Question: Provide a one-line summary of what is displayed.
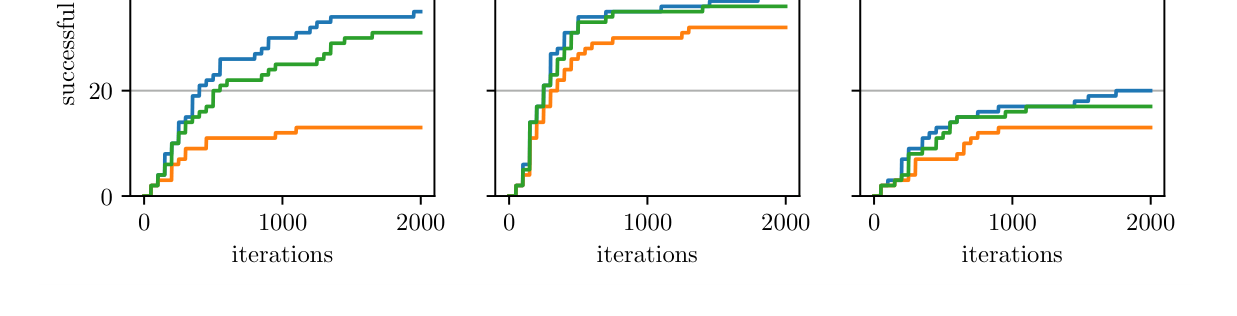
Answer: Data profile showing the relative performance of the low-level and high-level differentiation strategies. The curve for the original linear solver shows the number of problems solved (out of 65) such that ∥x −xref∥2 < 10−4. The curves for the differentiated linear solvers show the number of problems solved such that  ∂x